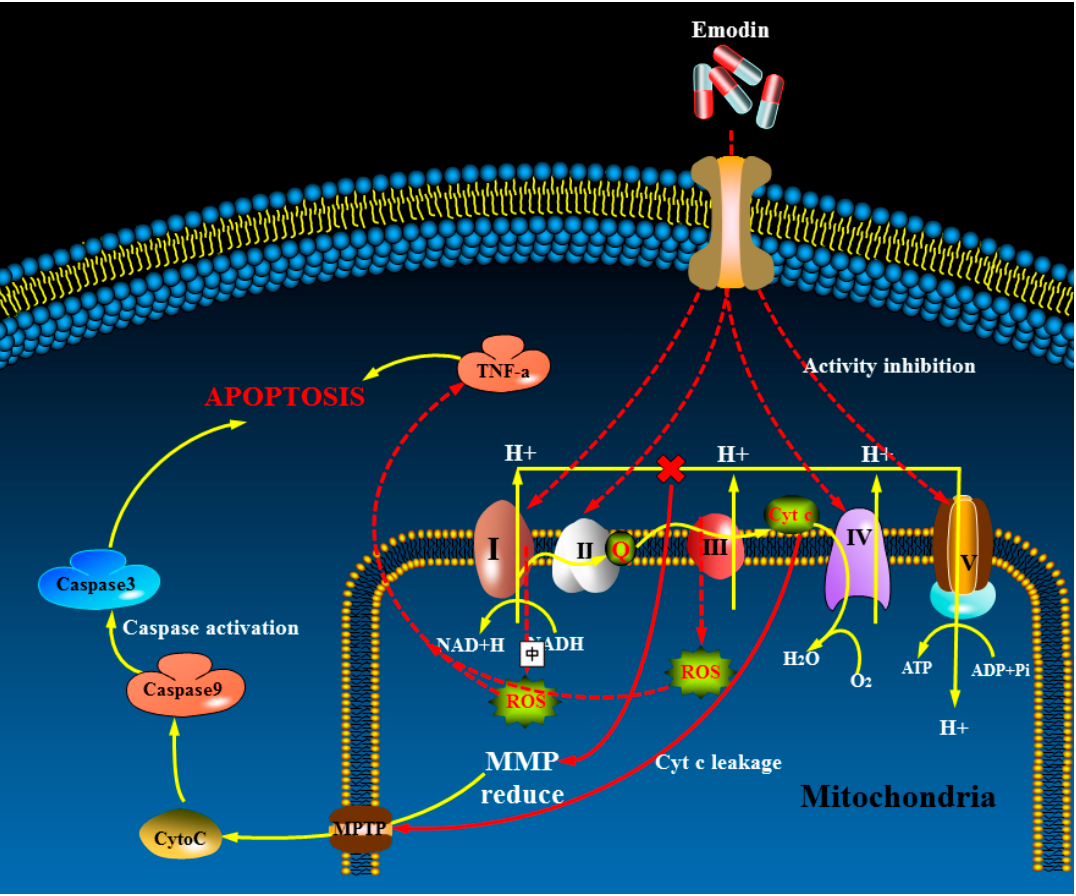
Figure 9. The possible hepatotoxicity signal pathway of apoptosis induced by emodin.